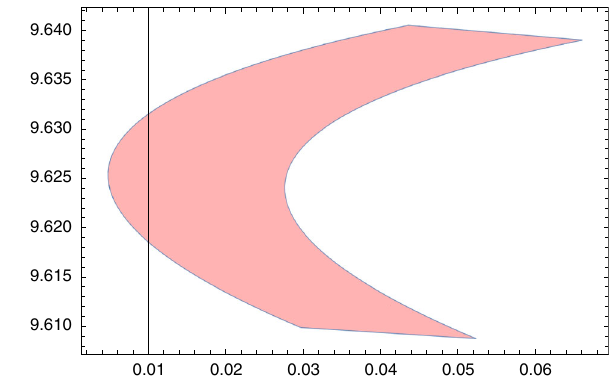
Fig. 11 Parametric plot of n s vs r ( x axis ≡ r and y axis ≡ 10 n s )